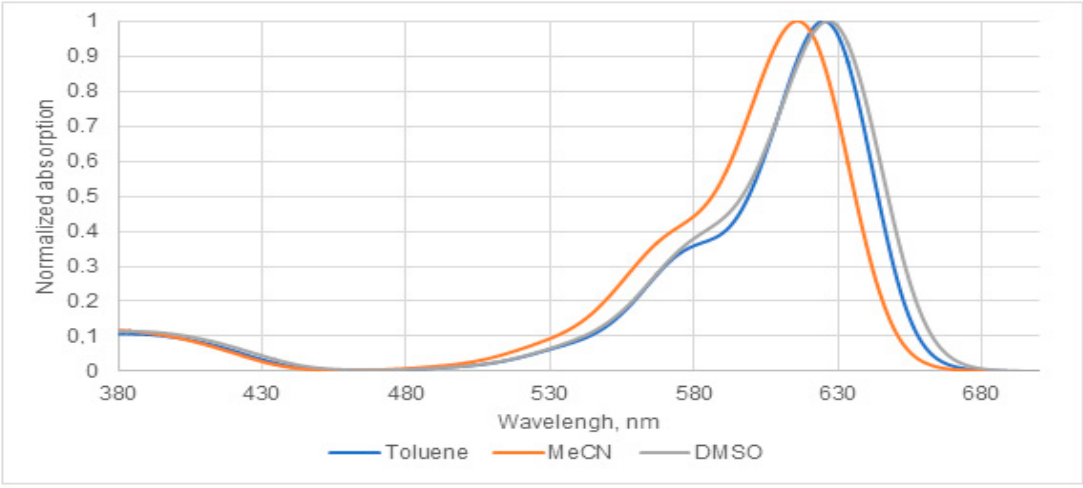
Figure 1. The electronic absorption and fluorescence spectra of BODIPY 1 . Table 1. Spectroscopic and photophysical characteristics of BODIPY 1 at 22 °C.